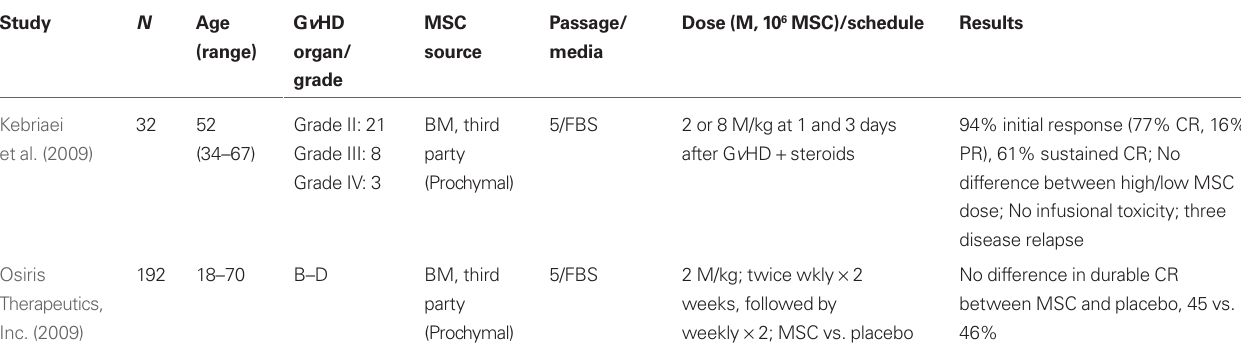
Table 2 | Results of clinical trails utilizing MSC for de novo acute G v